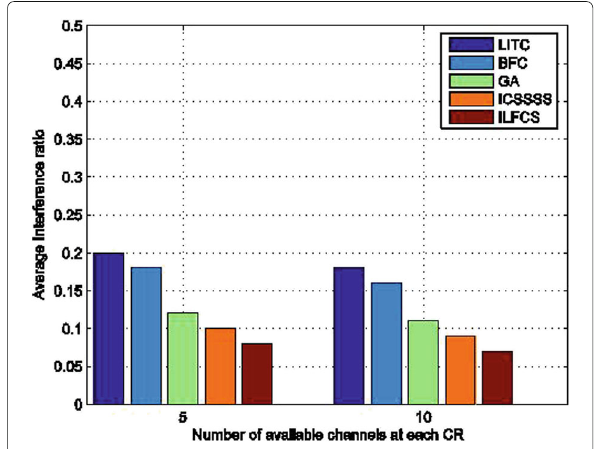
Fig. 17 Average interference ratio for LITC, BFC, GA, ICSSSS, and ILFCS in case of low PU activity. The results of different simulation experiments to measure average interference ratio for LITC, BFC, GA, ICSSSS, and ILFCS in case of low PU activity are shown